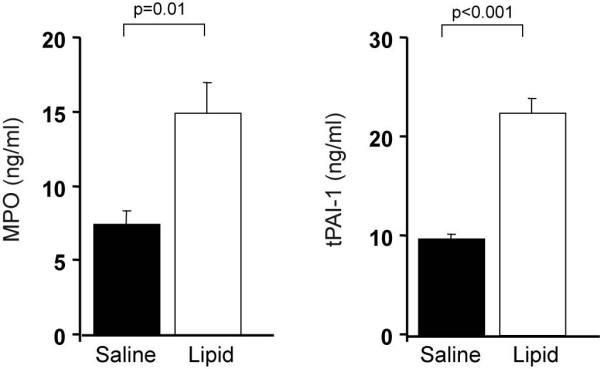
Compared to a saline, FFA increased doubled plasma MPO from 7.5 ± 0.9 to 15 ± 25 ng/ml (p = 0.01) and tPAI-1 by 132% from 9.7 ± 0.6 to 22.5 ± 1.5 ng/ml (p < 0.001)